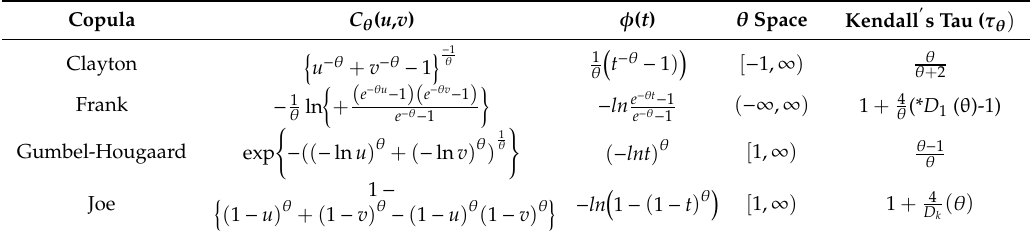
Table 1. Copula function, generating function φ (t) and the functional relationship of Kendal ( τ θ ) with the Copula parameter for selected Archimedean